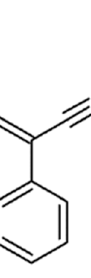
Figure 1. Chemical structure of 4-AN.